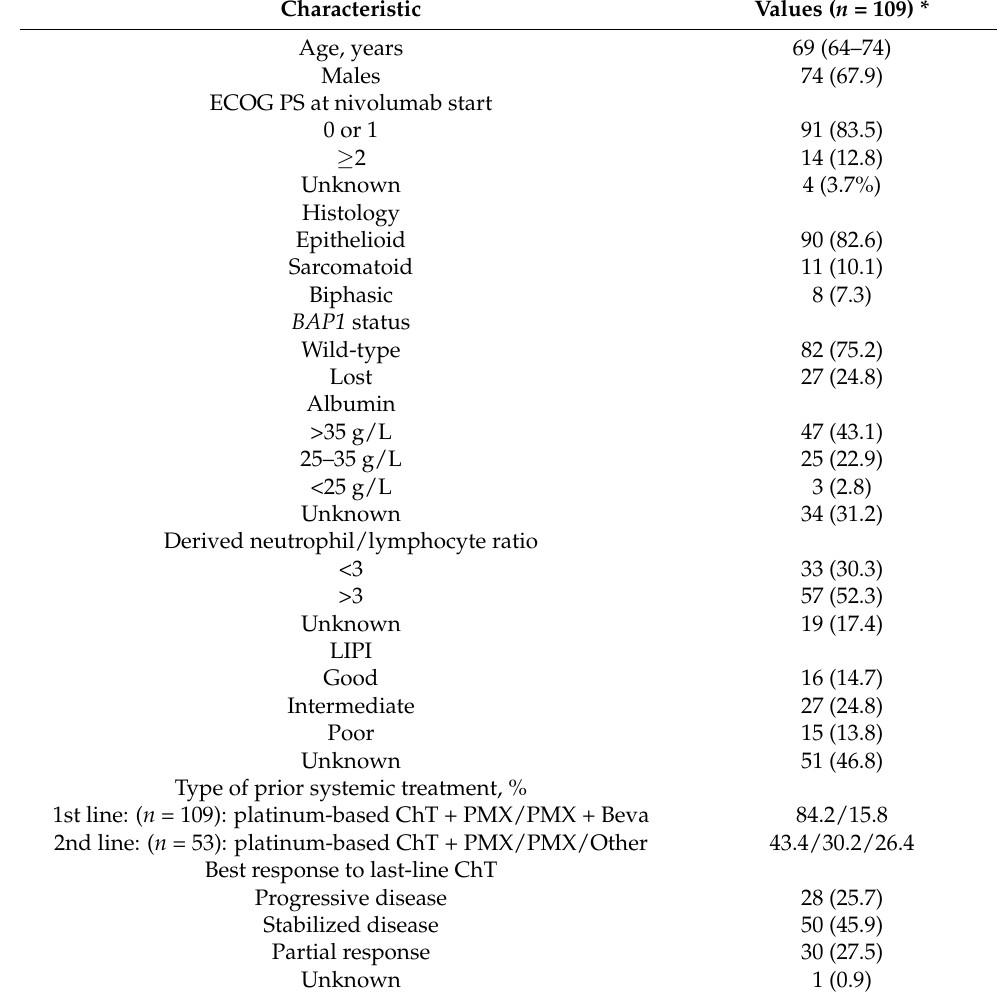
Table 1. Characteristics of the 109 MPM patients at nivolumab